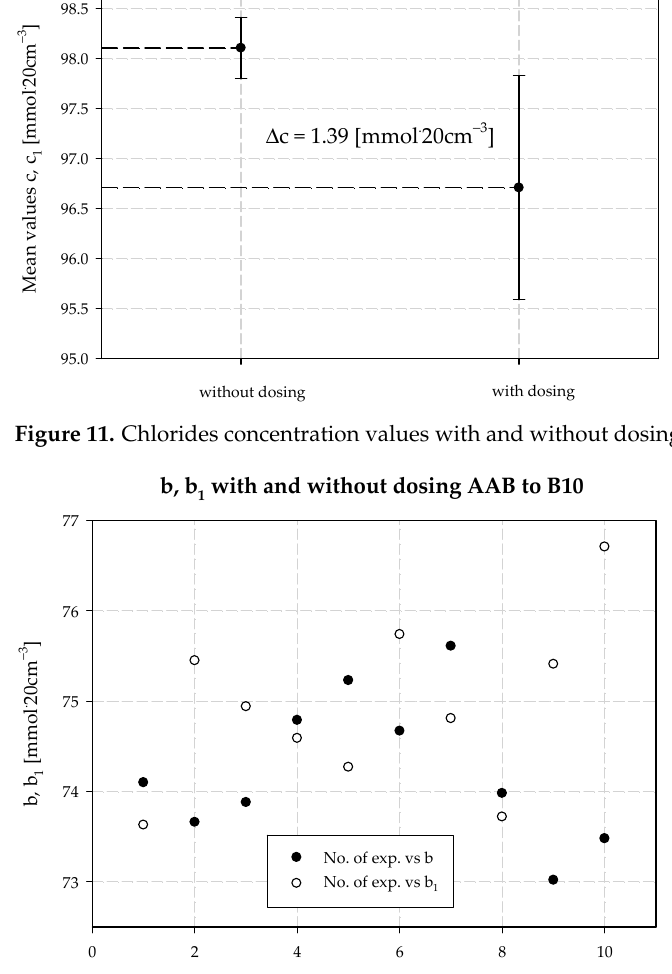
No. of exp. No. of exp. No. of exp.